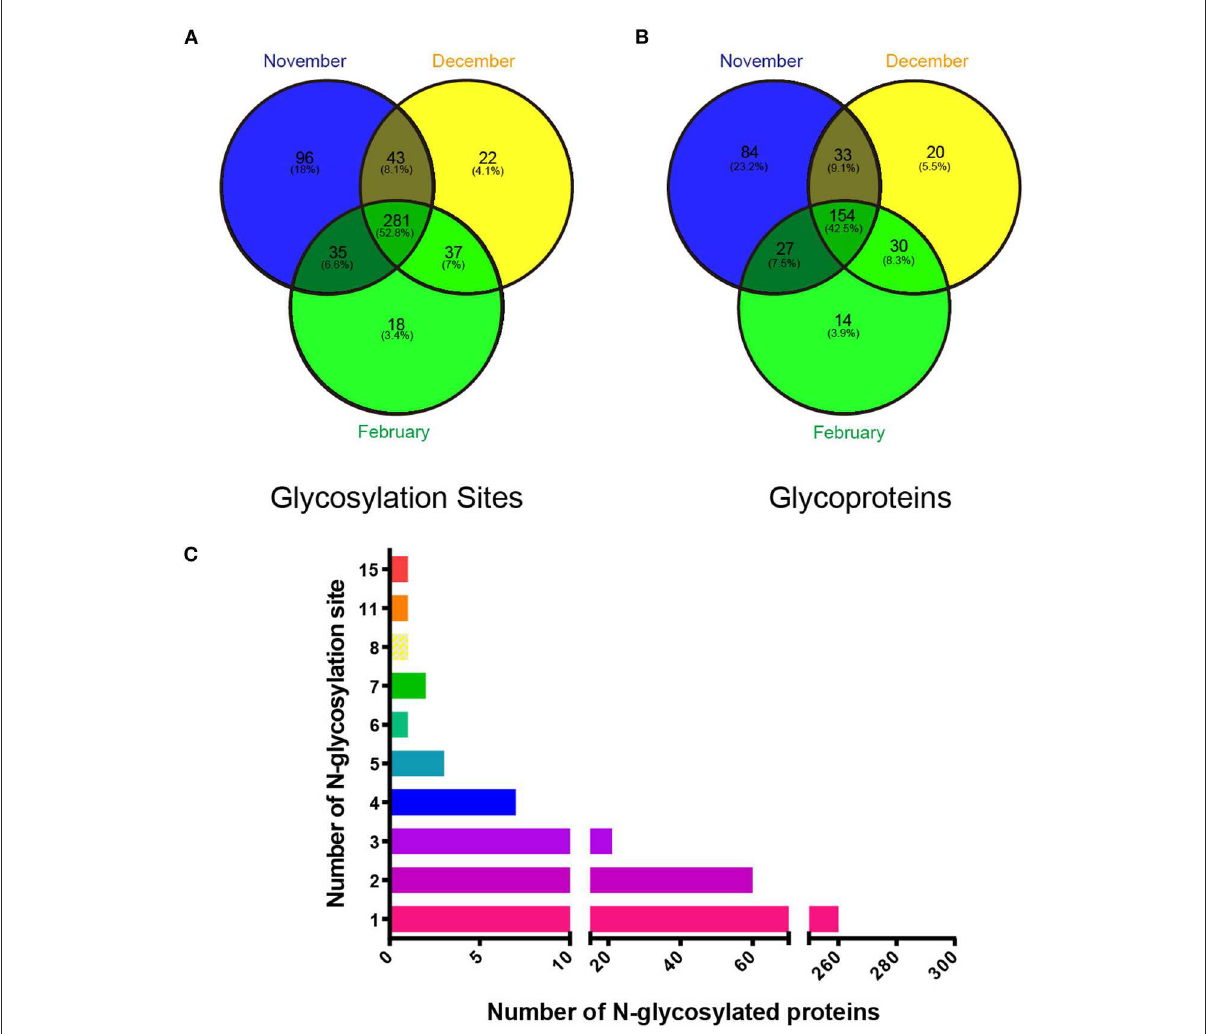
FIGURE2 Identification of glycoproteins and their N-glycosylation sites in mink testes at different stages during spermatogenesis. (A) Changes in testis protein N-glycosylation sites at different stages. (B) Changes in testicular N-glycosylated proteins at different stages. (C) Changes in the number of N-glycosylation sites on different glycosylated